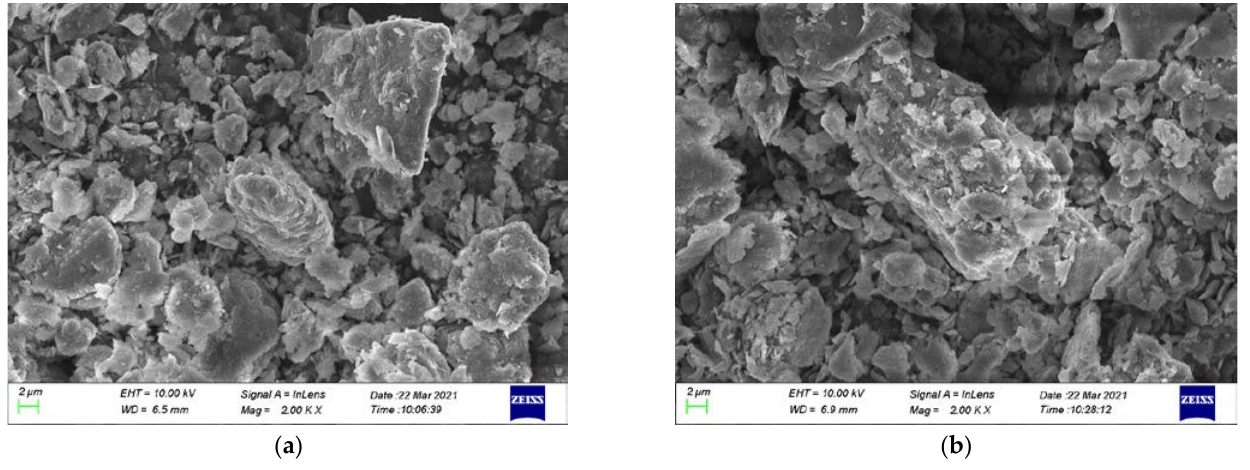
Figure 5. SEM micrographs of SB and SBCCr. ( a ) Micromorphology of sodium bentonite. ( b ) Micromorphology of sodium bentonite loaded with chromium catechol.